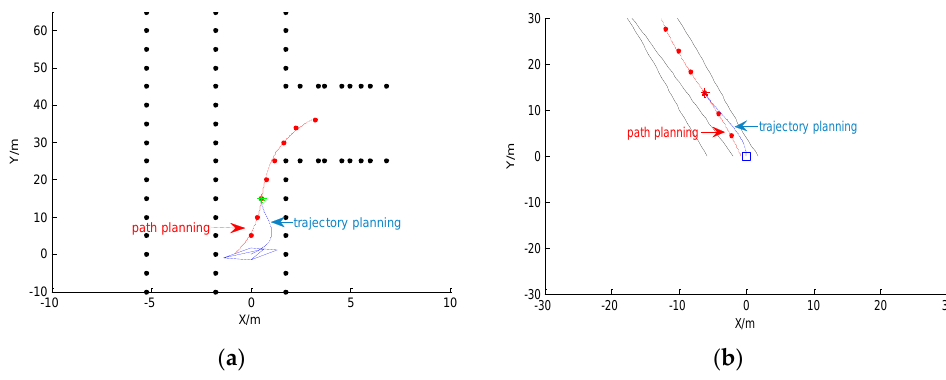
Figure 13. Right turn. ( a ) Global coordinates; ( b ) local coordinates .